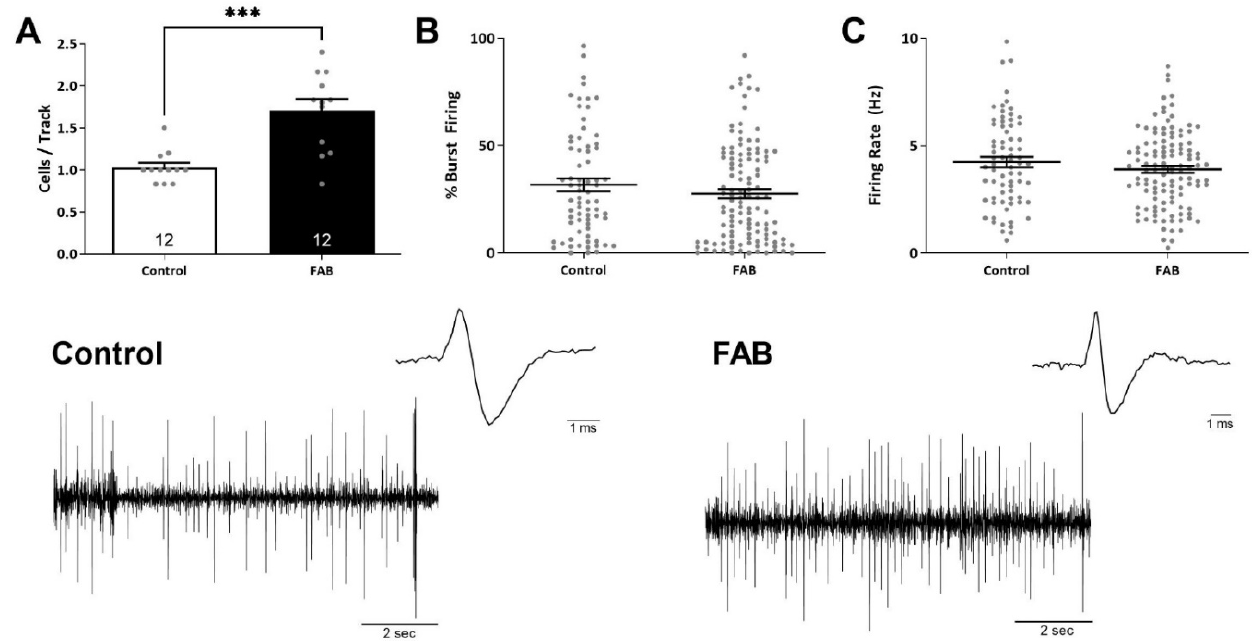
Figure 2. FAB rats exhibited increased ventral tegmental area (VTA) dopamine neuron population activity ( A ). No changes were observed in the percent burst firing ( B ) or the average firing rates ( C ) of dopamine neurons. Representative dopamine neuron trace and action potential from a control (left) and FAB (right) rat. *** p = 0.001.